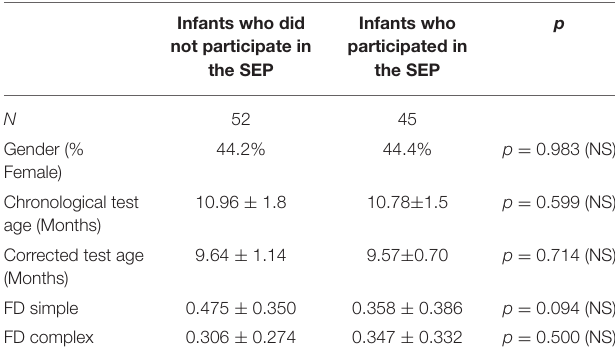
TABLE 2 | Demographic and gaze behavior comparisons of infants who participated in the SEP and those who did not. Infants who did not participate